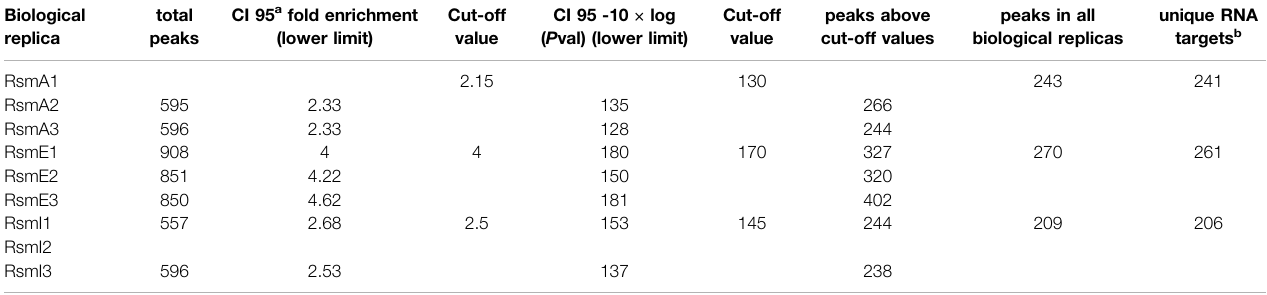
TABLE 2 | Summary of the high throughput data analysis of Rsm targets in P. putida KT2440. Biological